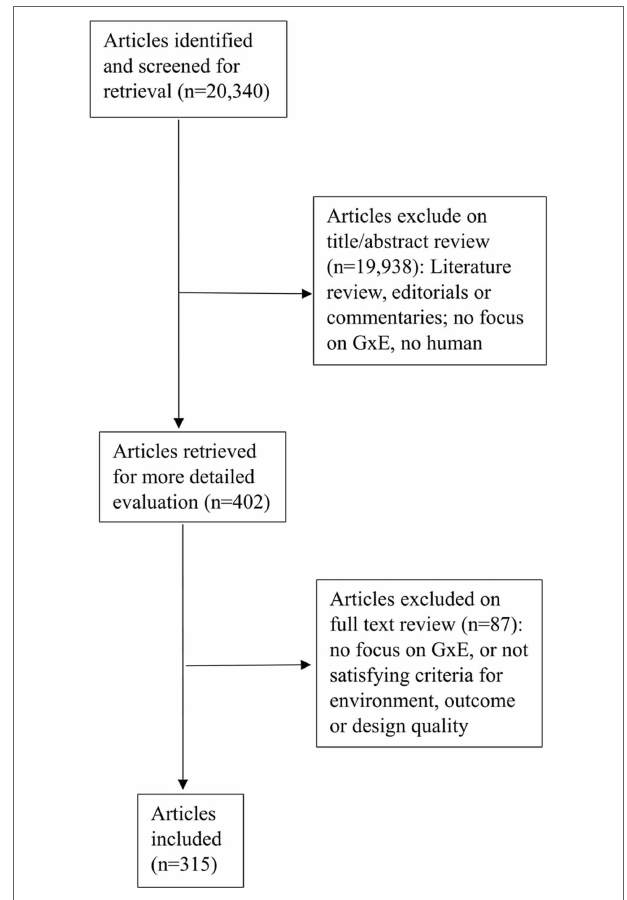
FiGURe 1 | Flowchart showing the search and selection of articles in this